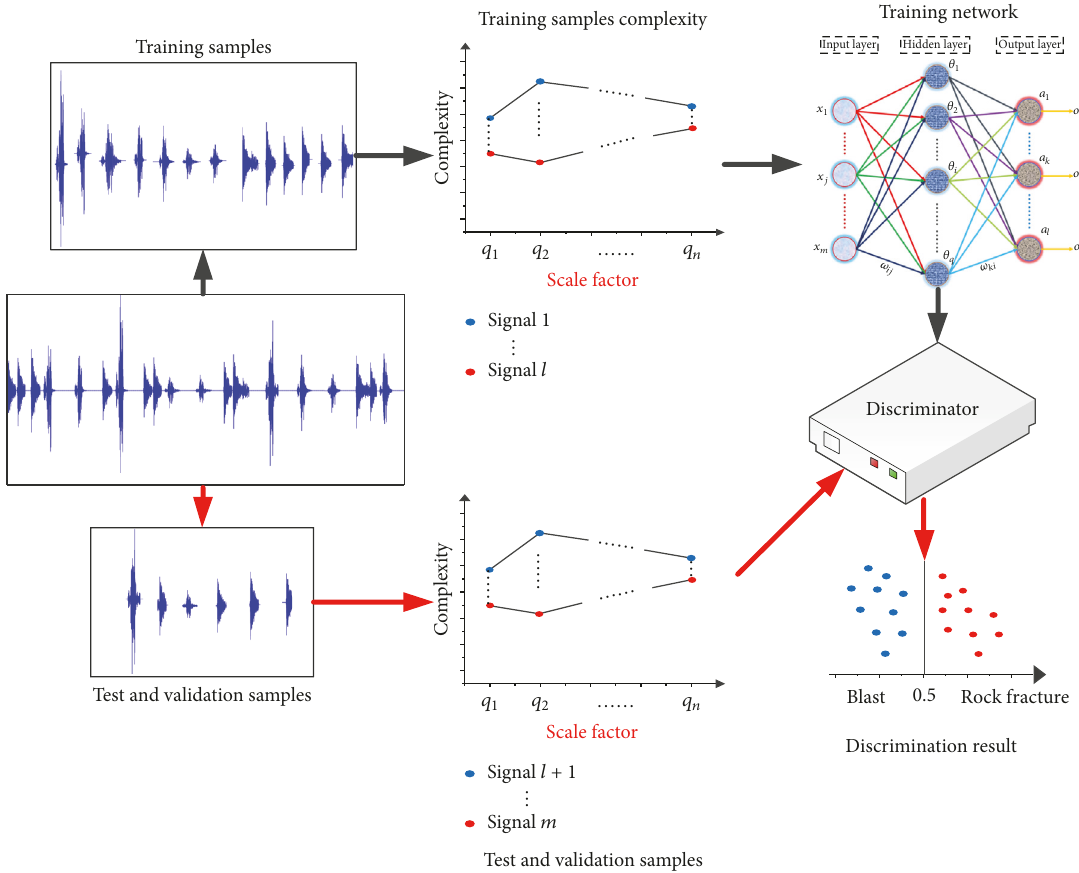
Figure 1: Sketch of the whole discrimination process.